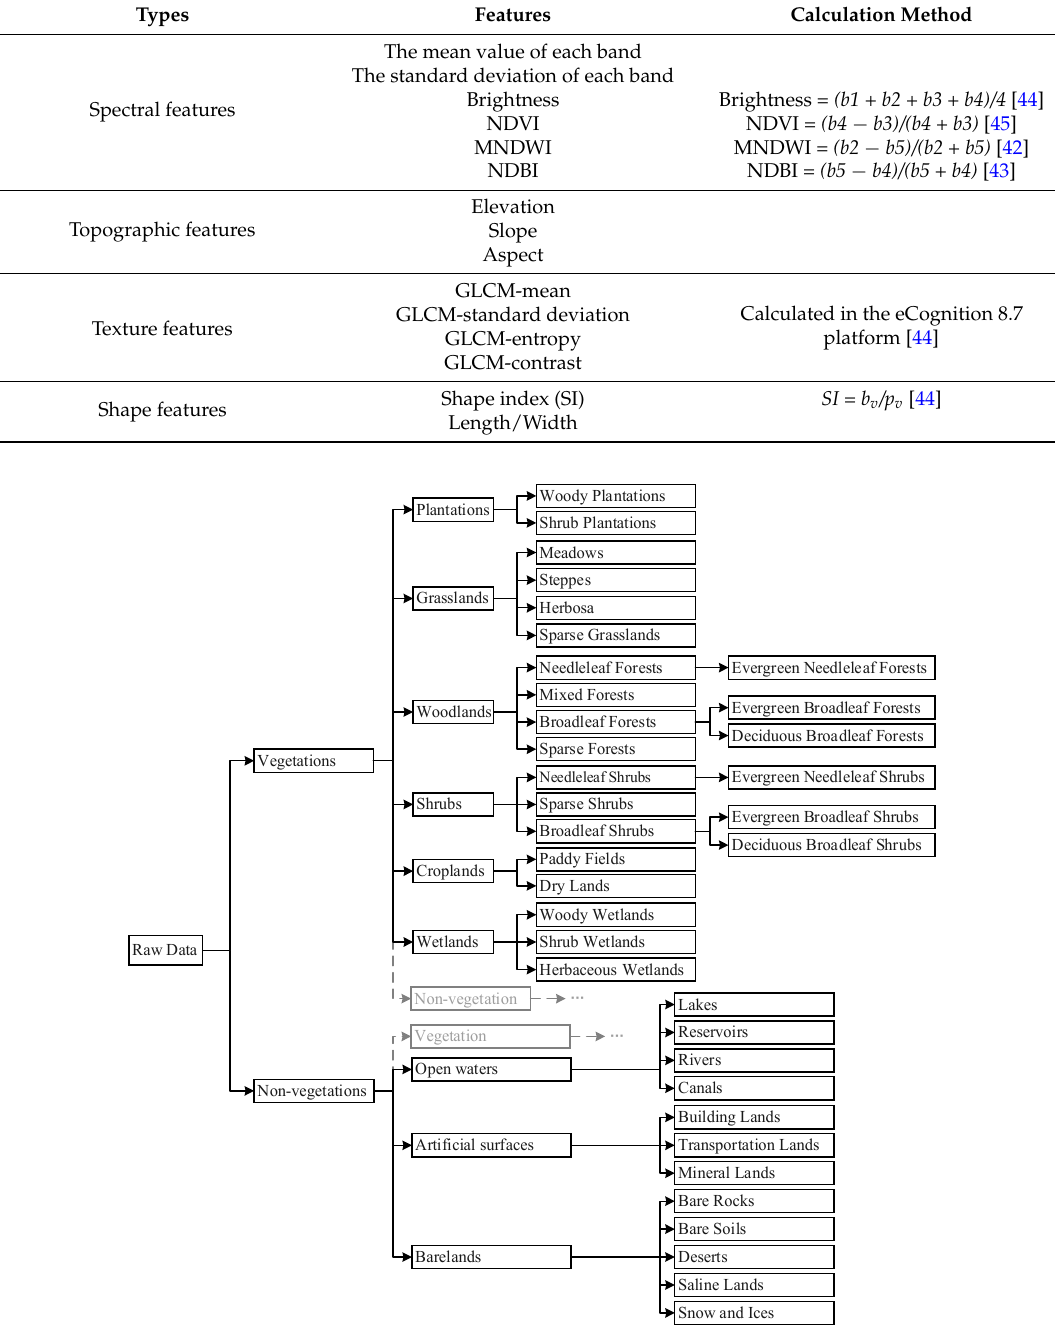
Table 2. The multi-type features used in land cover classification. The b1 , b2 , b3 , b4 and b5 denote respectively the blue, green, red, near infrared and mid-infrared band of satellite images. The GLCM is gray level co-occurrence matrix, which has a good ability to distinguish texture features of natural objects. The b v is the border length of image object, and the p v is the area of image object.